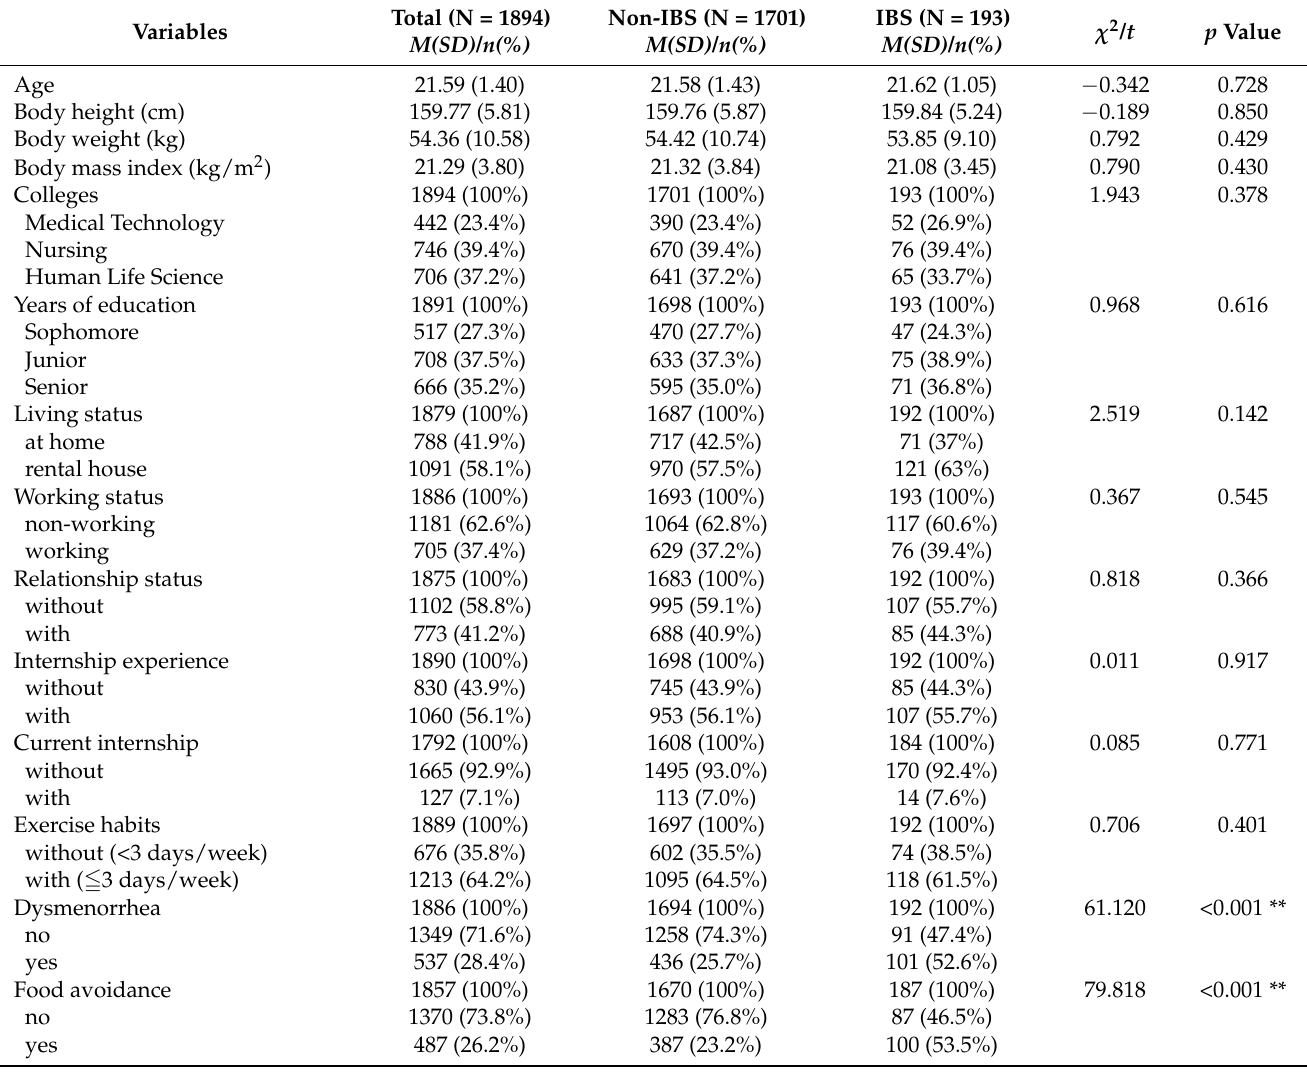
Table 2. Demographic characteristics of female students with or without irritable bowel syndrome (N =